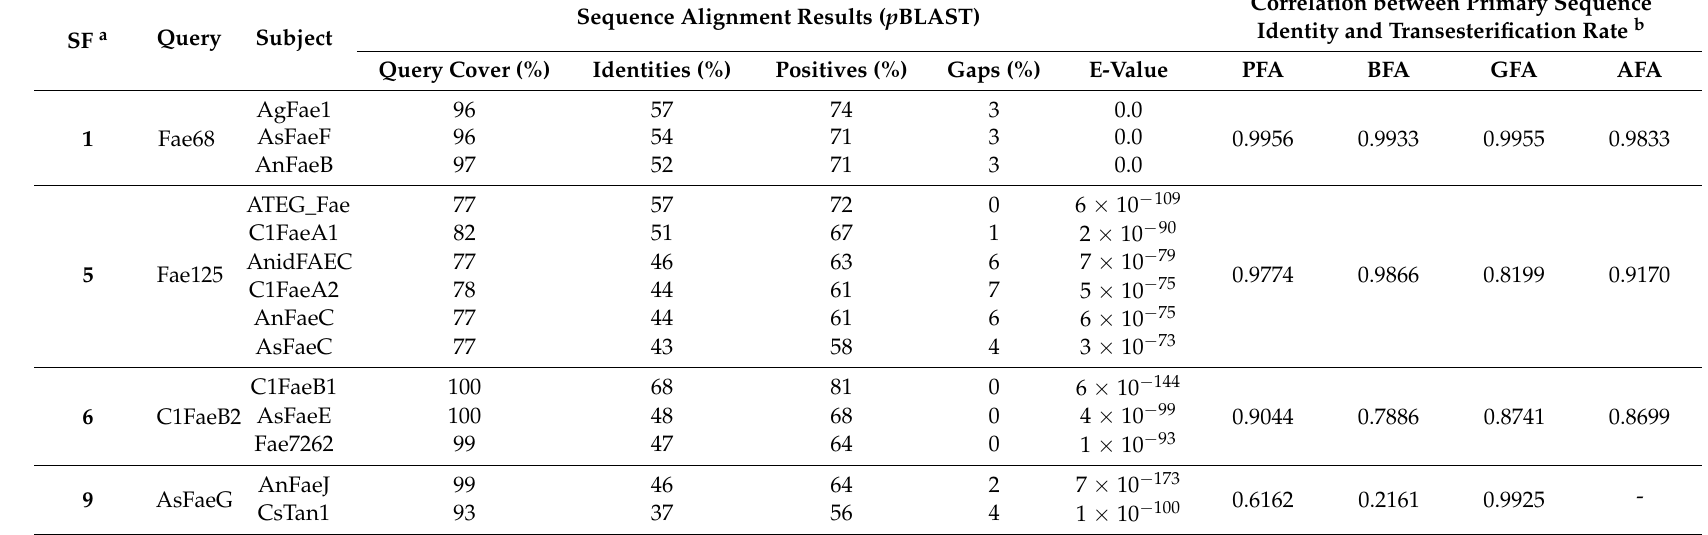
Table 3. Primary sequence homology between members of phylogenetic subfamilies SF1, SF5, SF6, and SF9 and correlation with transesterification